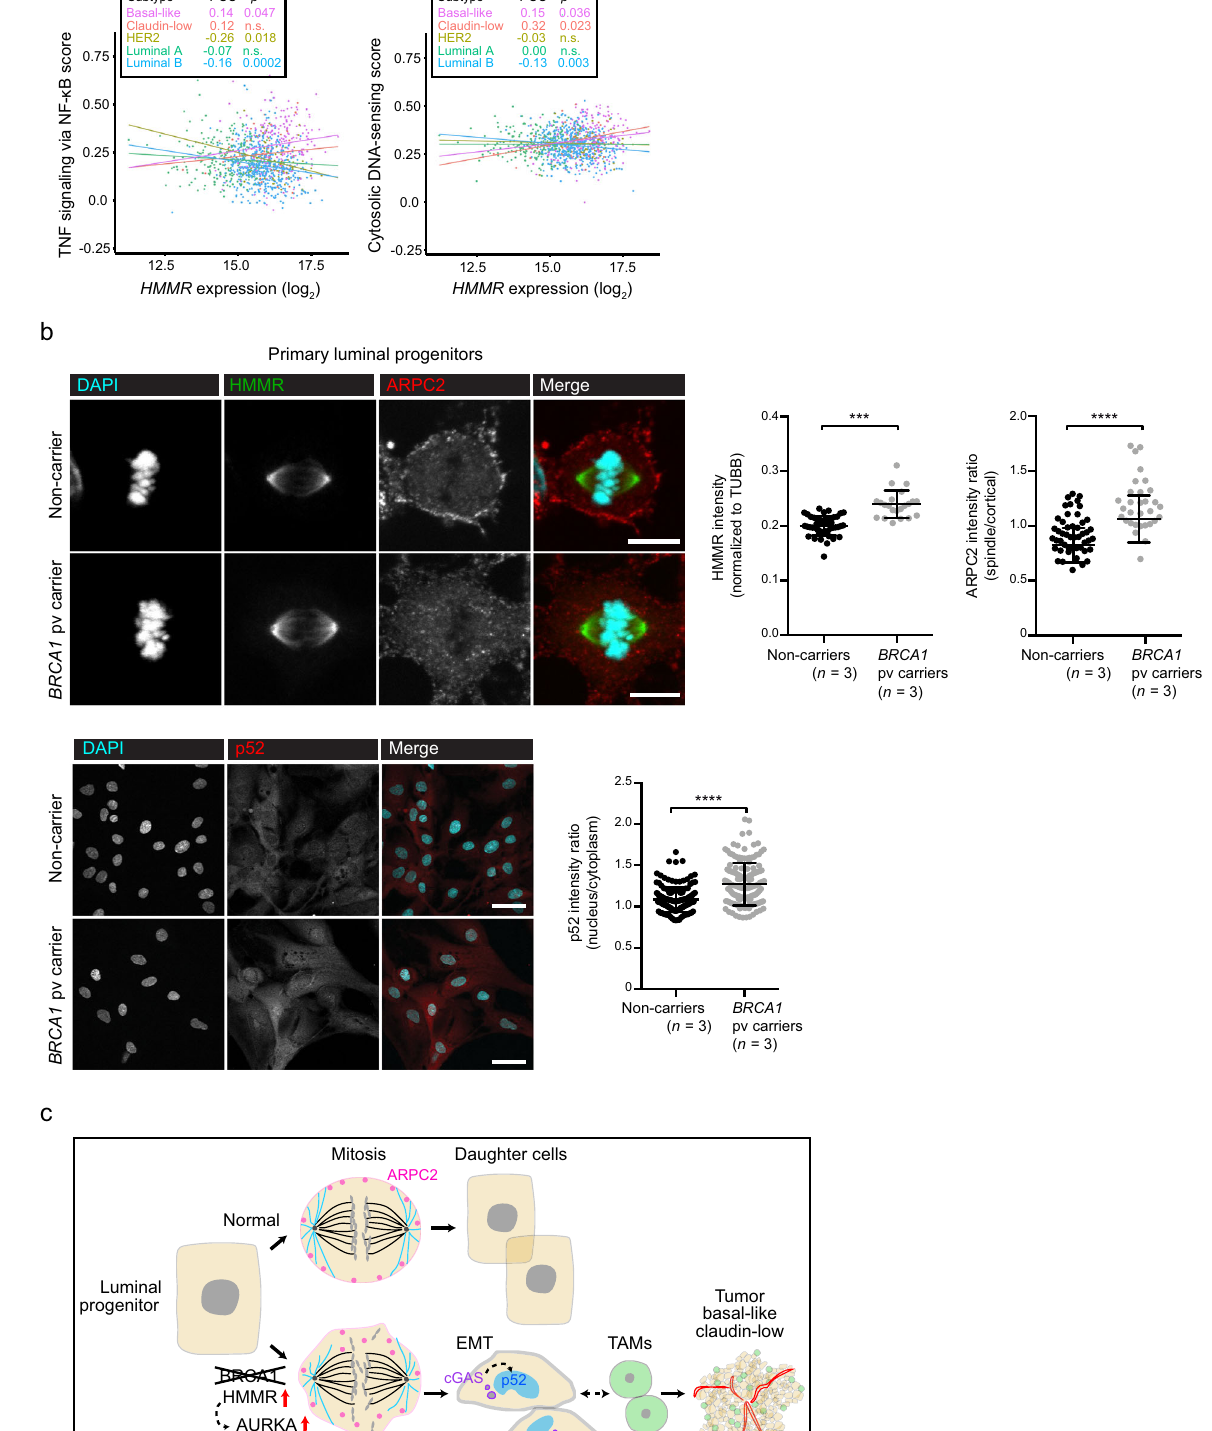
pathologists. Tumor features were scored blindly relative to their genotype, fol- lowing established criteria for mouse studies 62 . Gene expression analysis of mouse tumors . The mRNAs from tumors were extracted using TRIzol (Thermo Fisher Scienti fi c) and, following quality controls, single-end-sequenced at the IRB ’ s facility in Barcelona. The RNA-seq reads were